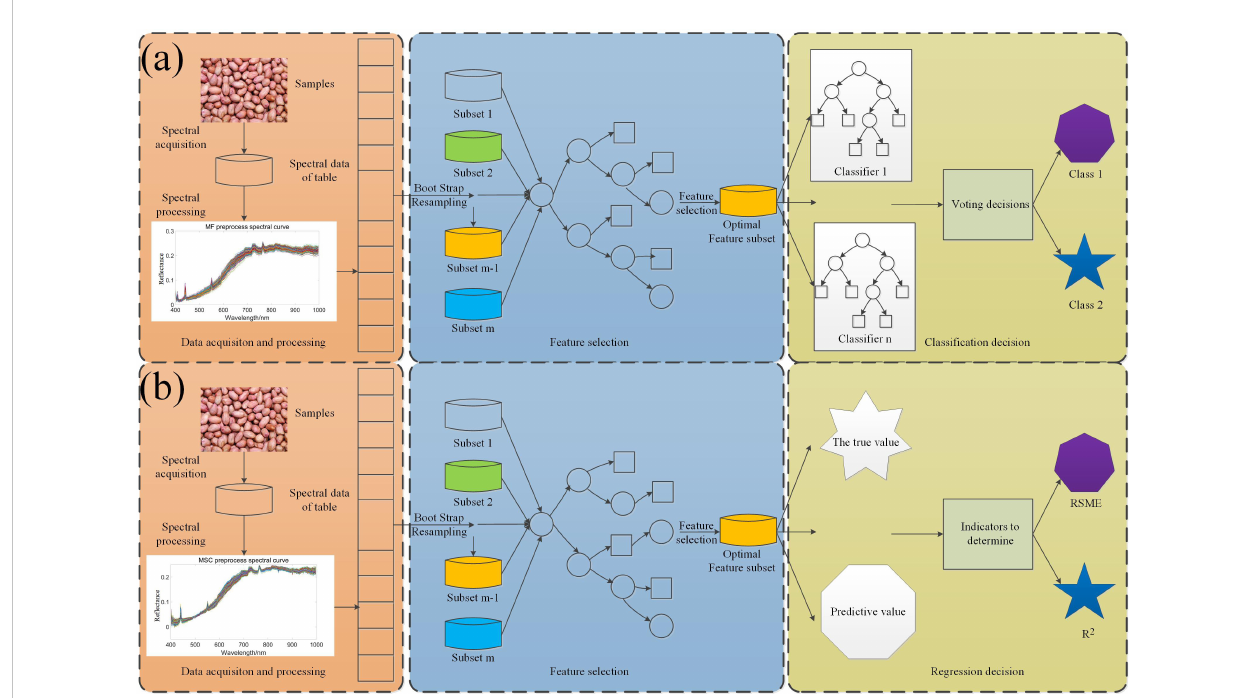
FIGURE 2 Algorithm fl ow chart: (A) Peanut seed viability classi fi cation model; (B) SOD regression